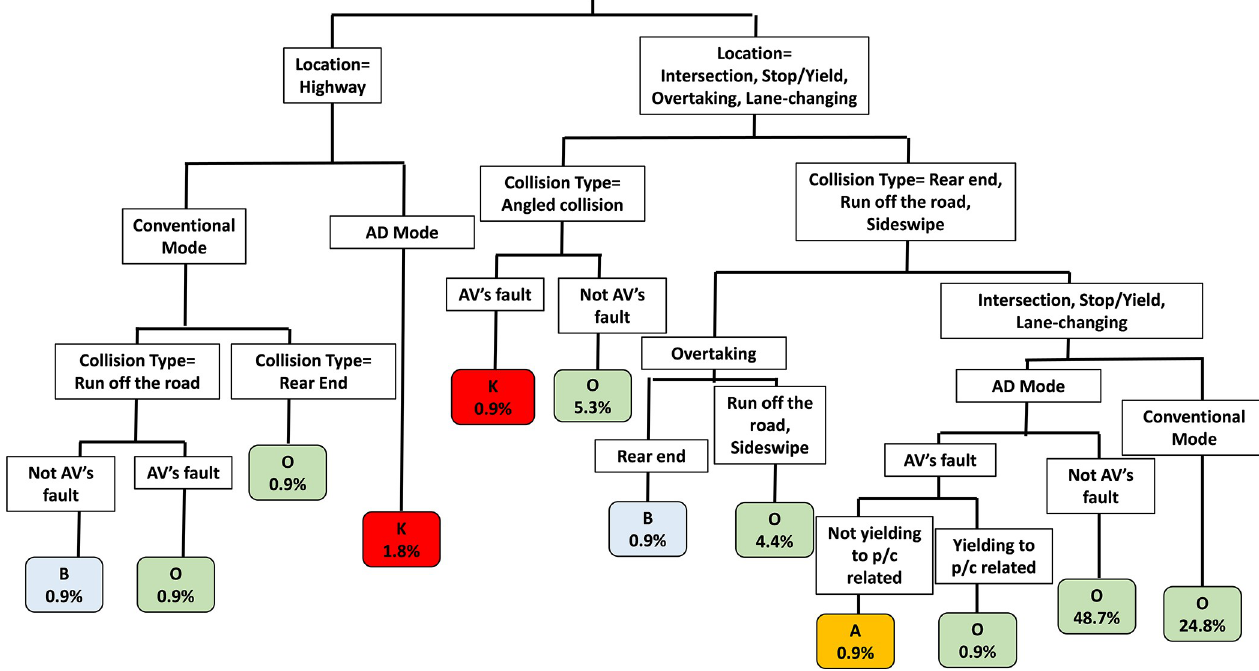
Fig 3. Mechanism of crash severity in collisions with AV